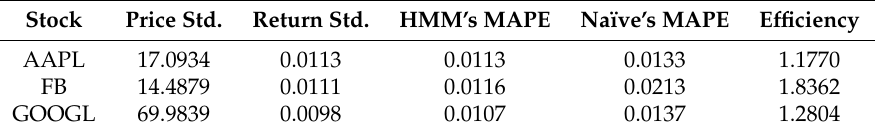
Table 2. Comparison of MAPE of stock price predictions of Apple, Google, and Facebook from 15 August 2016 to 11 August 2017, between the HMM and the naïve forecast model. Stock Price Std. Return Std.